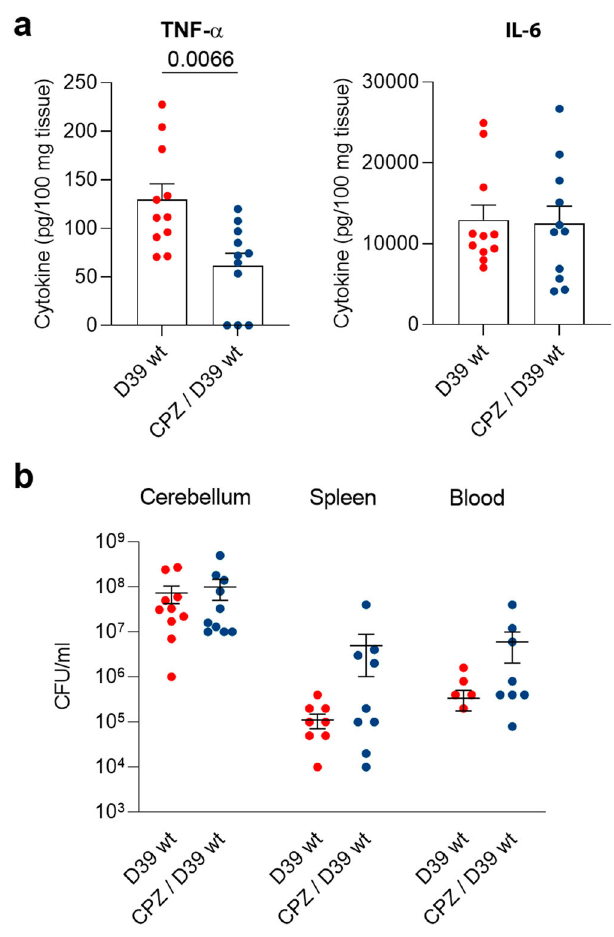
Fig.9|Treatment ofmicewithpneumococcalmeningitiswiththeendocytosis inhibitor chlorpromazine (CPZ). a Reduction of TNF- α but not IL-6 release after CPZ treatment in meningitis animals (CPZ/D39 wt) versus meningitis only animals (D39 wt) 18h after the induction of pneumococcal meningitis. b Bacterial CFUs in samples from cerebellum, spleen, and blood showing equivalent numbers in ani- malswithandwithoutCPZtreatment(zerolevelsinspleenandlungsarenotshown due to the logarithmicscale but are included in the mean).Allvaluesrepresent the mean±SEM, and each animal is indicated with a dot, n =11 animals (D39 wt) and n =11 animals (CPZ/D39 wt), Mann – Whitney U -test, all tests are two-tailed, exact p -valuesareindicated(ifsigni fi cant).SourcedataareprovidedasaSourceData fi